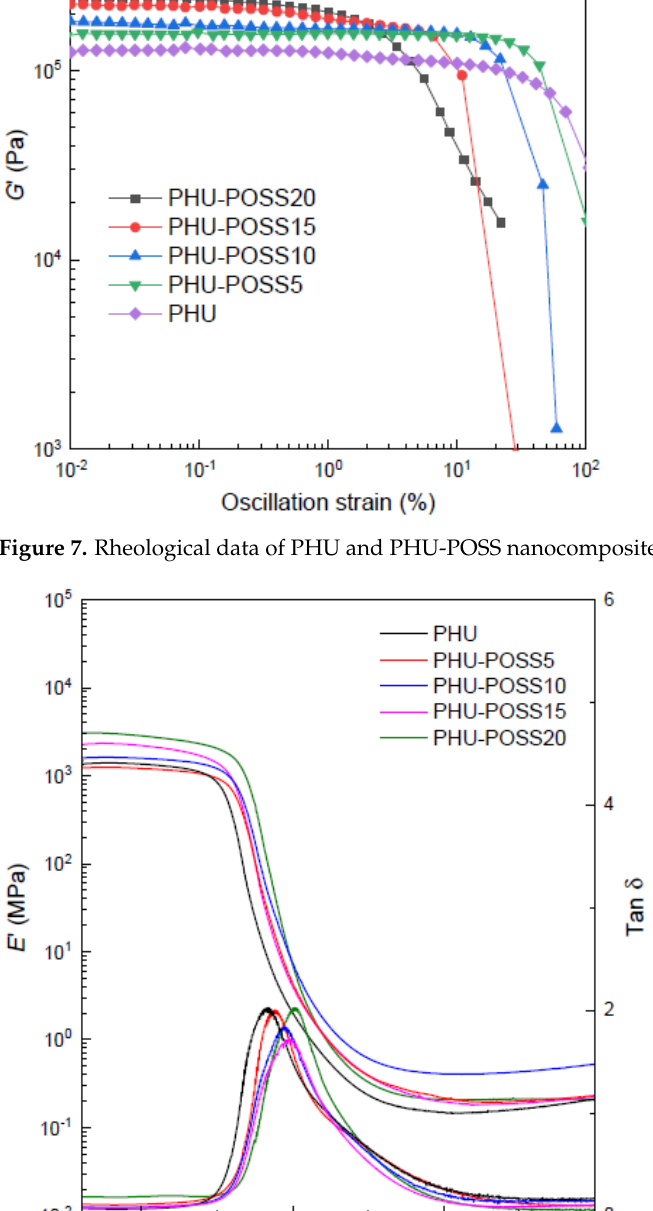
Figure 7. Rheological data of PHU and PHU-POSS nanocomposites with a strain sweep.